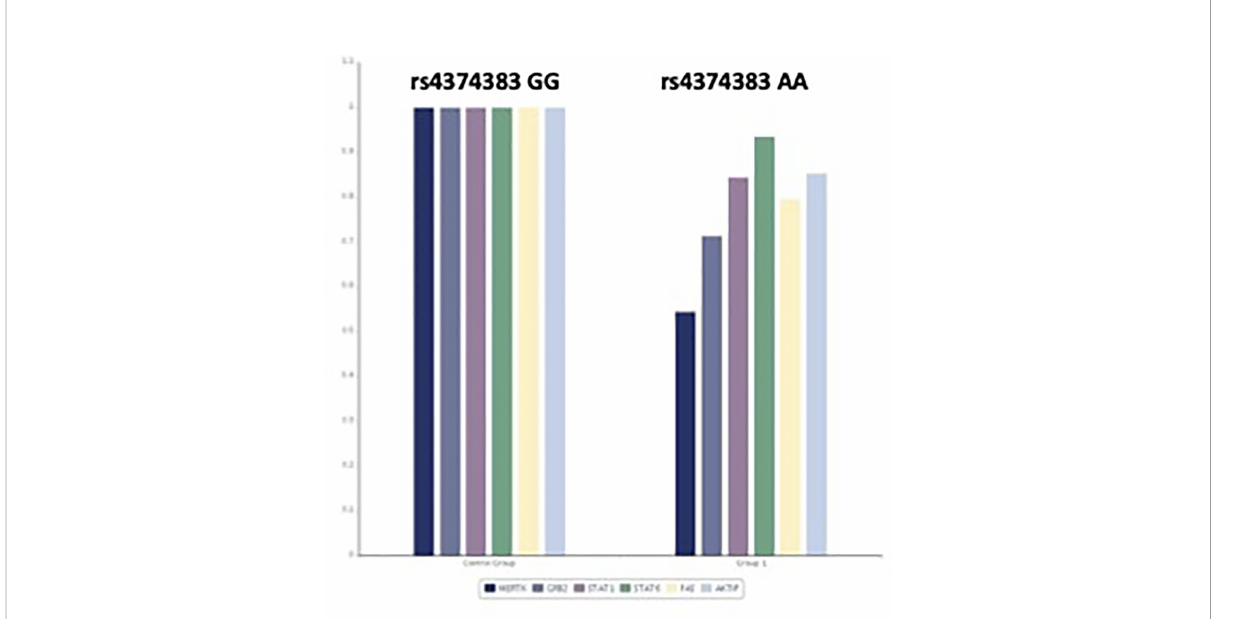
FIGURE 1 Differential gene expression in CHC patients with GG MERTK genotype (N = 19) and AA genotype (N = 16). P-VALUE: MERTK 0.01; GRB2 0.10; STAT1 0.36; STAT6 0.2; FAS 0.07; AKTIP 0.03.